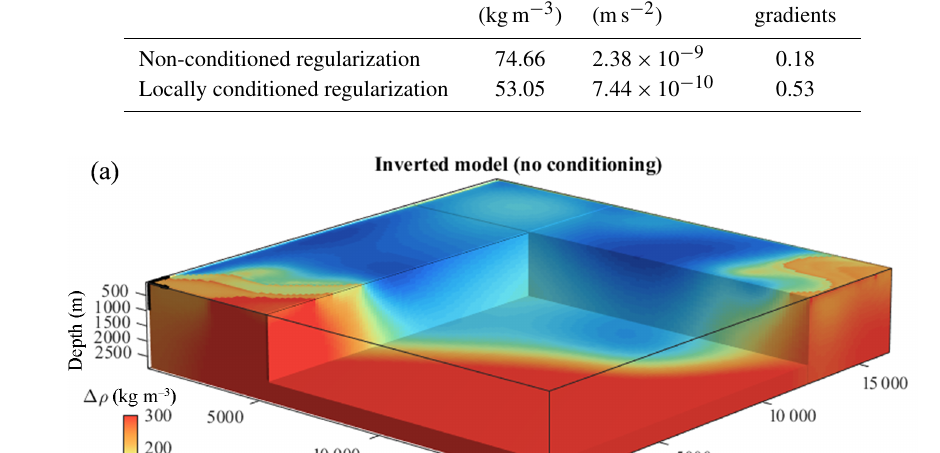
trieval of the causative bodies’ (e.g. the true model) structural